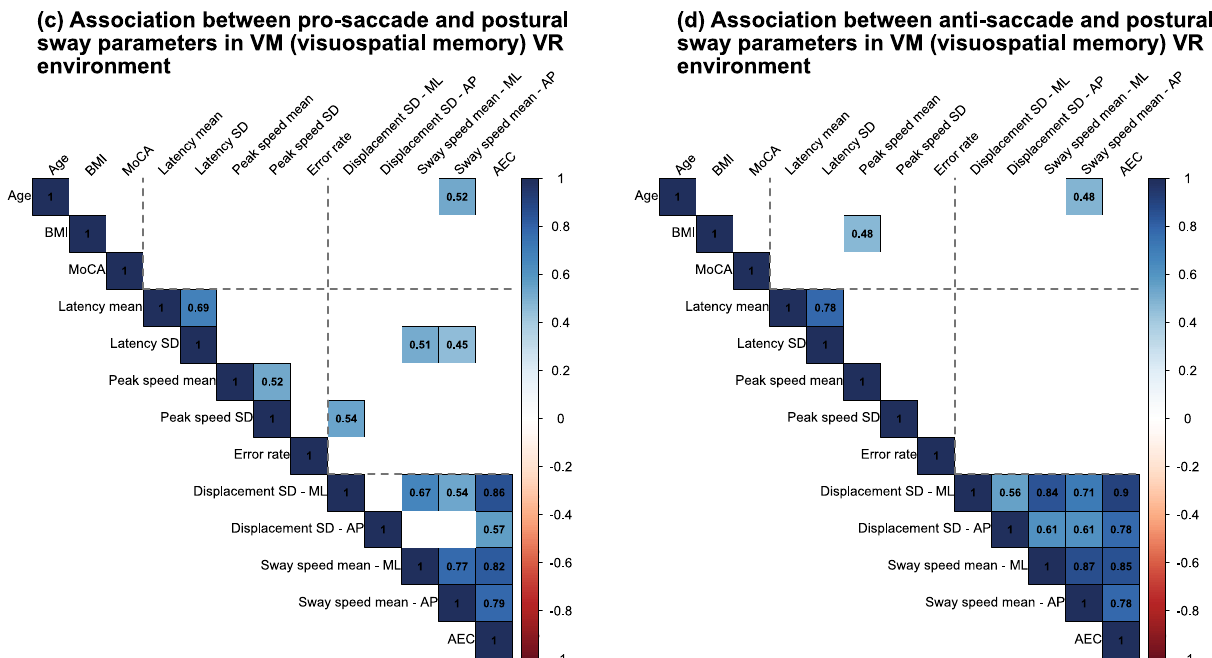
Figure 4. Correlation analysis between saccadic eye movements and postural sway in the baseline dual- task condition: ( a ) with pro-saccade task and ( b ) with anti-saccade task, and in dual-tasking paradigm with visuospatial memory (VM) task: ( c ) with pro-saccade task and ( d ) with anti-saccade task. More associations were observed in the baseline condition with anti-saccade task and the dual-task condition with visuospatial memory and pro-saccade tasks. More cognitively demanding tasks in these conditions could trigger the frontal lobe to be shared more commonly between saccade and posture